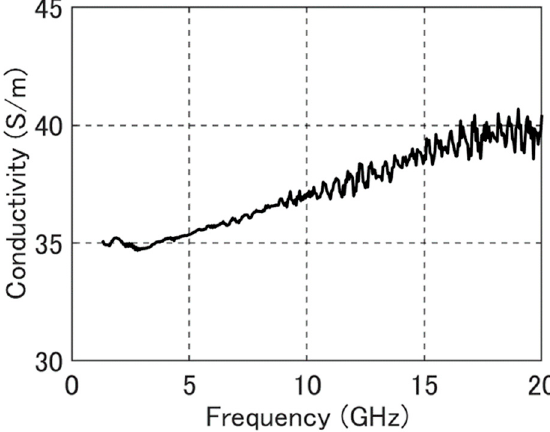
Figure 11. Estimated conductivity of the NaOH solution calculated by Equation (2).